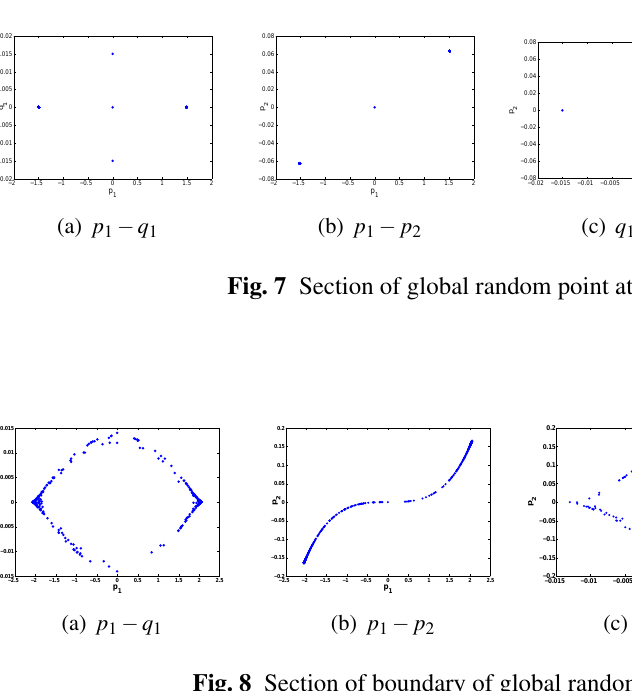
Fig. 8 Section of boundary of global random attractors for ϕ NGM 3 with case